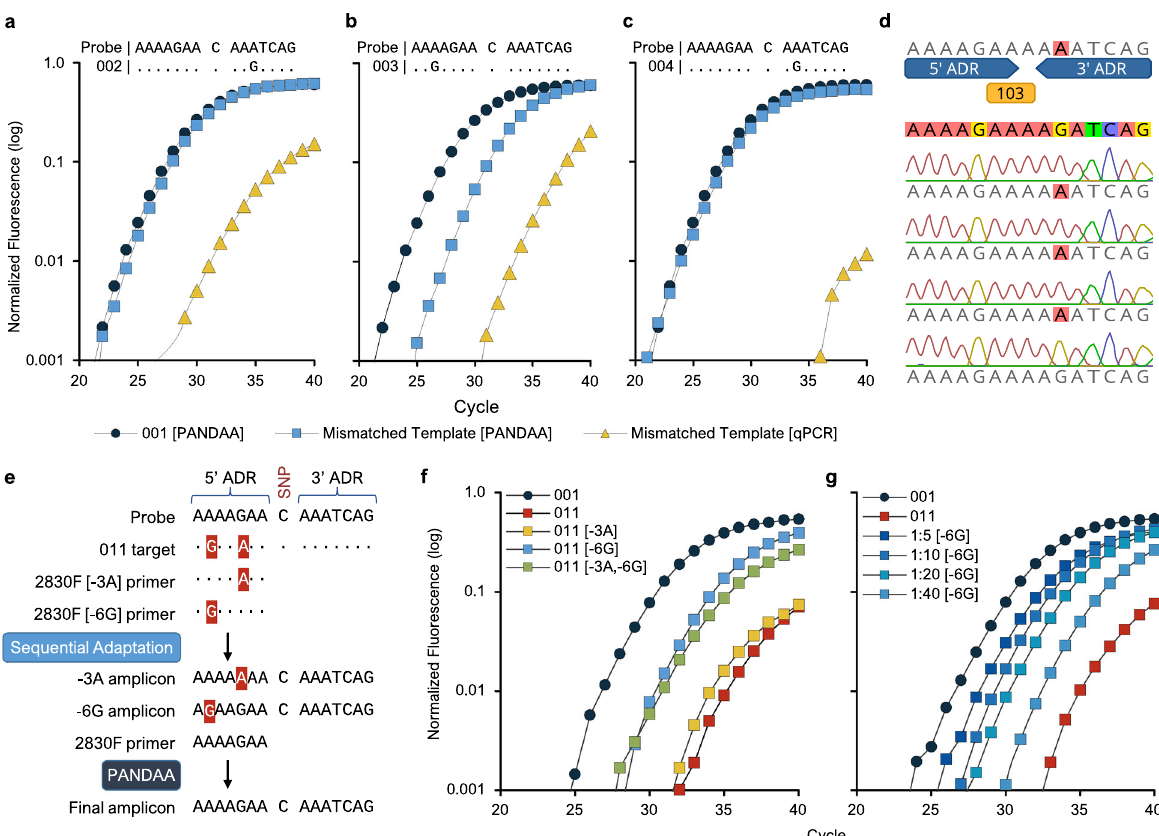
Fig. 4 PANDAA adaptation of the probe-binding site rescues qPCR performance. Conventional qPCR using PANDAA primers lacking the 3 ′ ADR was compared to PANDAA for the four most common K103 probe-binding sites (001 to 004).Template 001 (blue circles), which does not contain probe- binding site sequence variation, was included as a reference in each experiment against which the target containing a single-nucleotide variation was compared when using PANDAA (blue squares) versus conventional qPCR (yellow triangles). a PANDAA restored detection of template 002 to the same level as a target with no probe-binding site sequence variation. b Detection of template 003 was increased almost 40-fold when using PANDAA compared to conventional qPCR. c Conventional qPCR did not detect template 004, whereas PANDAA restored detection close to that observed with template 001. d Single-clone sequencing of the PANDAA amplicon demonstrated adaptation of the probe-binding site when using template 004 as the target. Adaptation was seen in 42/44 clones (95.5%). e Sequential adaptation overcomes multiple ADR mismatches. Template 011 contains two mismatches in the 5 ′ ADR, which must be adapted by the forward primer. By including a low concentration of 2830 F primers that contain only one of the two mismatches, adaptation can be performed in a stepwise manner such that the 2830 F PANDAA primer must only adapt one nucleotide variant rather than two. f Two primers, 2830 F [ − 3A] and 2830 F [ − 6G], each of which contains only a single mismatch, were added to separate PANDAA reactions at 10% of the 2830 F forward PANDAA primer concentration, and adaptation performance was evaluated with 103 copies per reaction template 001 or 011 DNA. 2830 F [ − 3A] resulted in a 0.9-cycle decrease compared to the 011 template with only the standard PANDAA primer. 2830 F [ − 6G] reduced the Cq by 4.8 cycles, whereas both sequential adaptation primers together led to a 4.1-cycle decrease. g A dose response was evident with 2830 F [ − 6G] sequential adaptation from 2.5 to 20% of the 2830 F forward PANDAA primer concentration. Results are the representative median of six